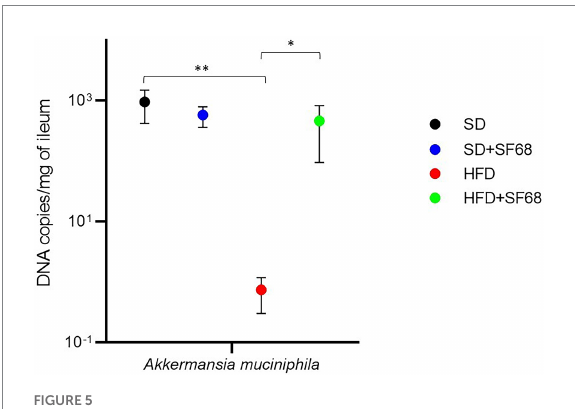
FIGURE 5 Variations in the absolute abundance of Akkermansia muciniphila in ileal tissues in both normal weight (SD) and obese (HFD) mice with or without SF68 administration. Statistical comparisons were carried out between SD and SD + SF68, and HFD and HFD + SF68. * p < 0.05; ** p < 0.01.